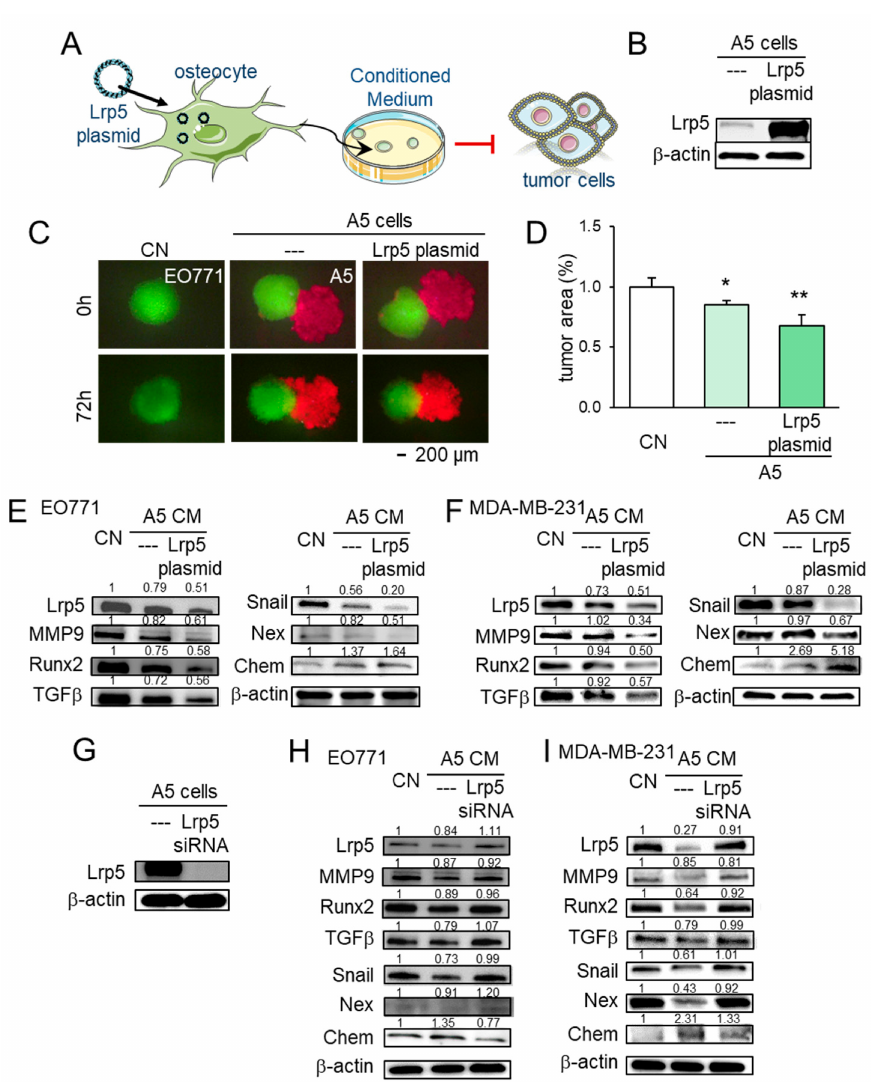
Figure 6. Effect of Lrp5 in osteocytes on EO771 and MDA-MB-231 breast cancer cells. The single and double asterisks indicate p < 0.05 and 0.01, respectively. CN = control, CM = conditioned medium, Chem = chemerin, Nex = nexin, cat K = cathepsin K. ( A , B ) Overexpression of Lrp5 in A5 osteocytes. ( C , D ) Shrinkage of EO771 tumor spheroids by the incubation with Lrp5-overexpressing osteocyte- derived CM and osteocytes. ( E , F ) Altered expression levels of Lrp5, MMP9, Runx2, TGF β , Snail, nexin, and chemerin in EO771 and MDA-MB-231 cells in response to A5 osteocyte-derived CM with and without Lrp5 overexpression. ( G – I ) Altered expression levels of Lrp5, MMP9, Runx2, TGF β , Snail, nexin, and chemerin in EO771 and MDA-MB-231 cells in response to A5 osteocyte-derived CM in the presence and absence of RNA silencing with Lrp5